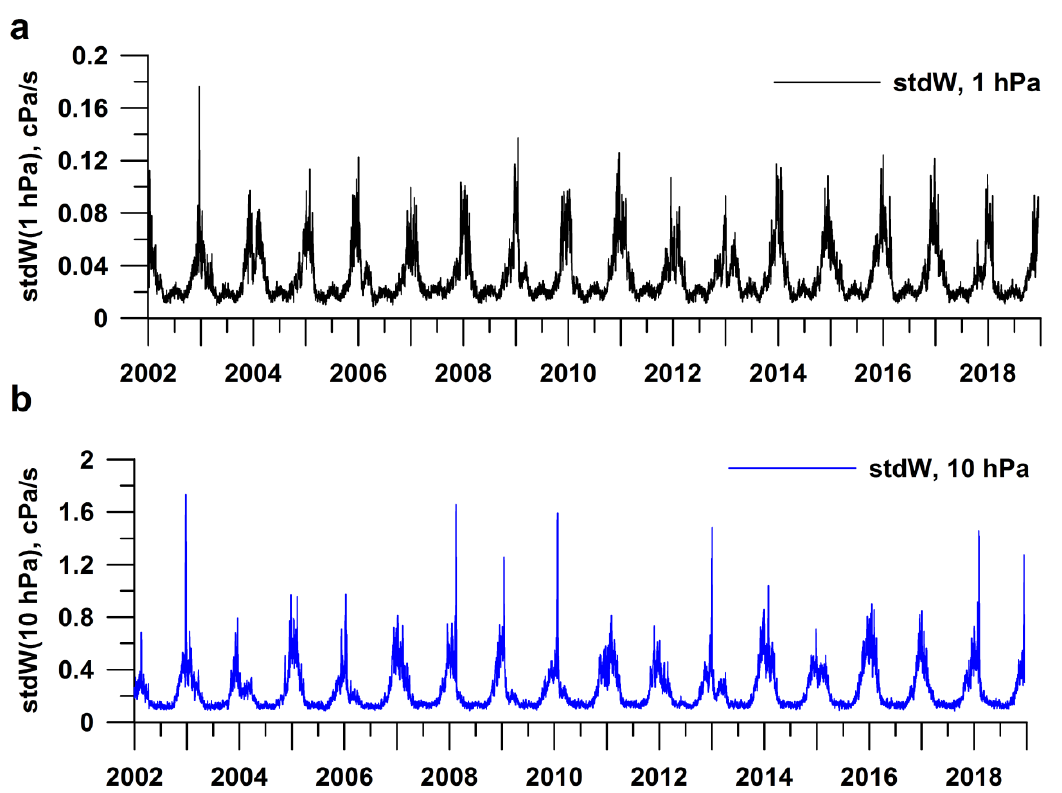
Figure 5. StdW variations at 60°N at 1 hPa ( a , black) and 10 hPa ( b , dark blue).